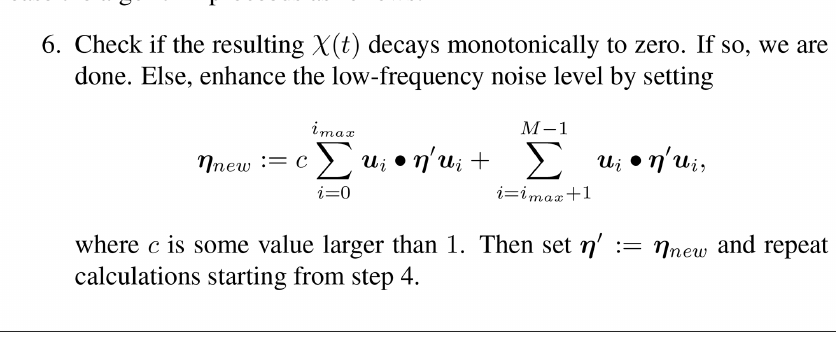
Figure 1. Final RFI algorithm (see text for